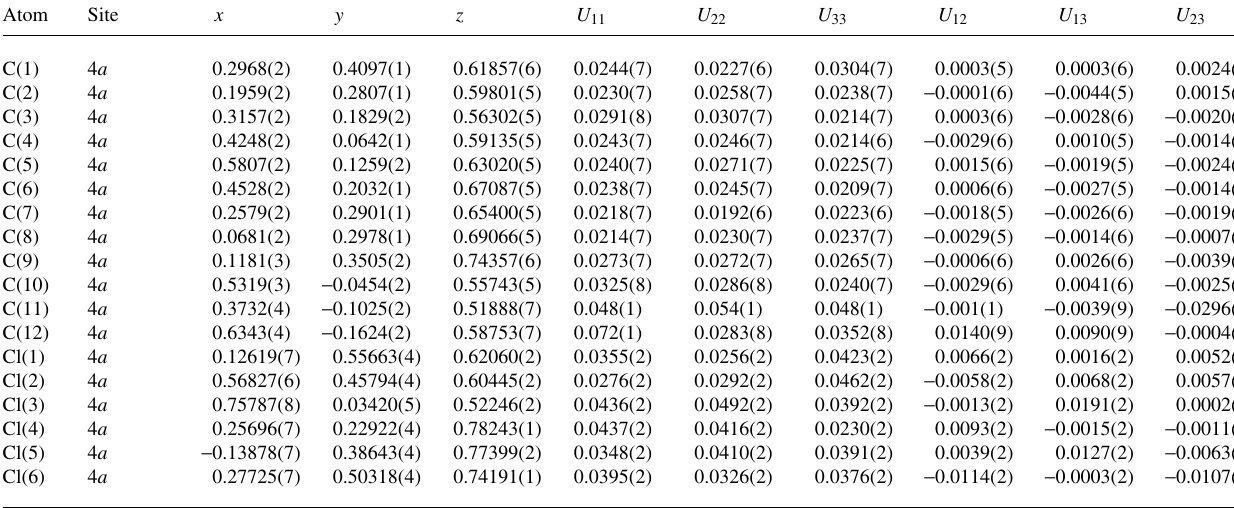
figuration of a New Cyclopropanic Compound. Derived from the Sesquiterpene * -Himachalene. Z. Naturforsch. 59B (2004) 1177-1179. 8. Wang, M.-L.; Hsieh, Y.-M.; Chang, R.-Y.: Kinetics of dichlorocyclo- propanationusing4-(dimethyloctylammonium)propansultanand1,4-bis- (triethylmethylamonium)benzene dibromide as new phase transfer cata- lysts. React. Kinet. Catal. Lett. 81 (2004) 49-56. 9. Sheldrick,G.M.:SHELXS-97.ProgramfortheSolutionofCrystalStruc- tures. University of Göttingen, Germany 1997. 10.Sheldrick, G. M.: SHELXL-97. Program for the Refinement of Crystal Structures. University of Göttingen, Germany 1997.